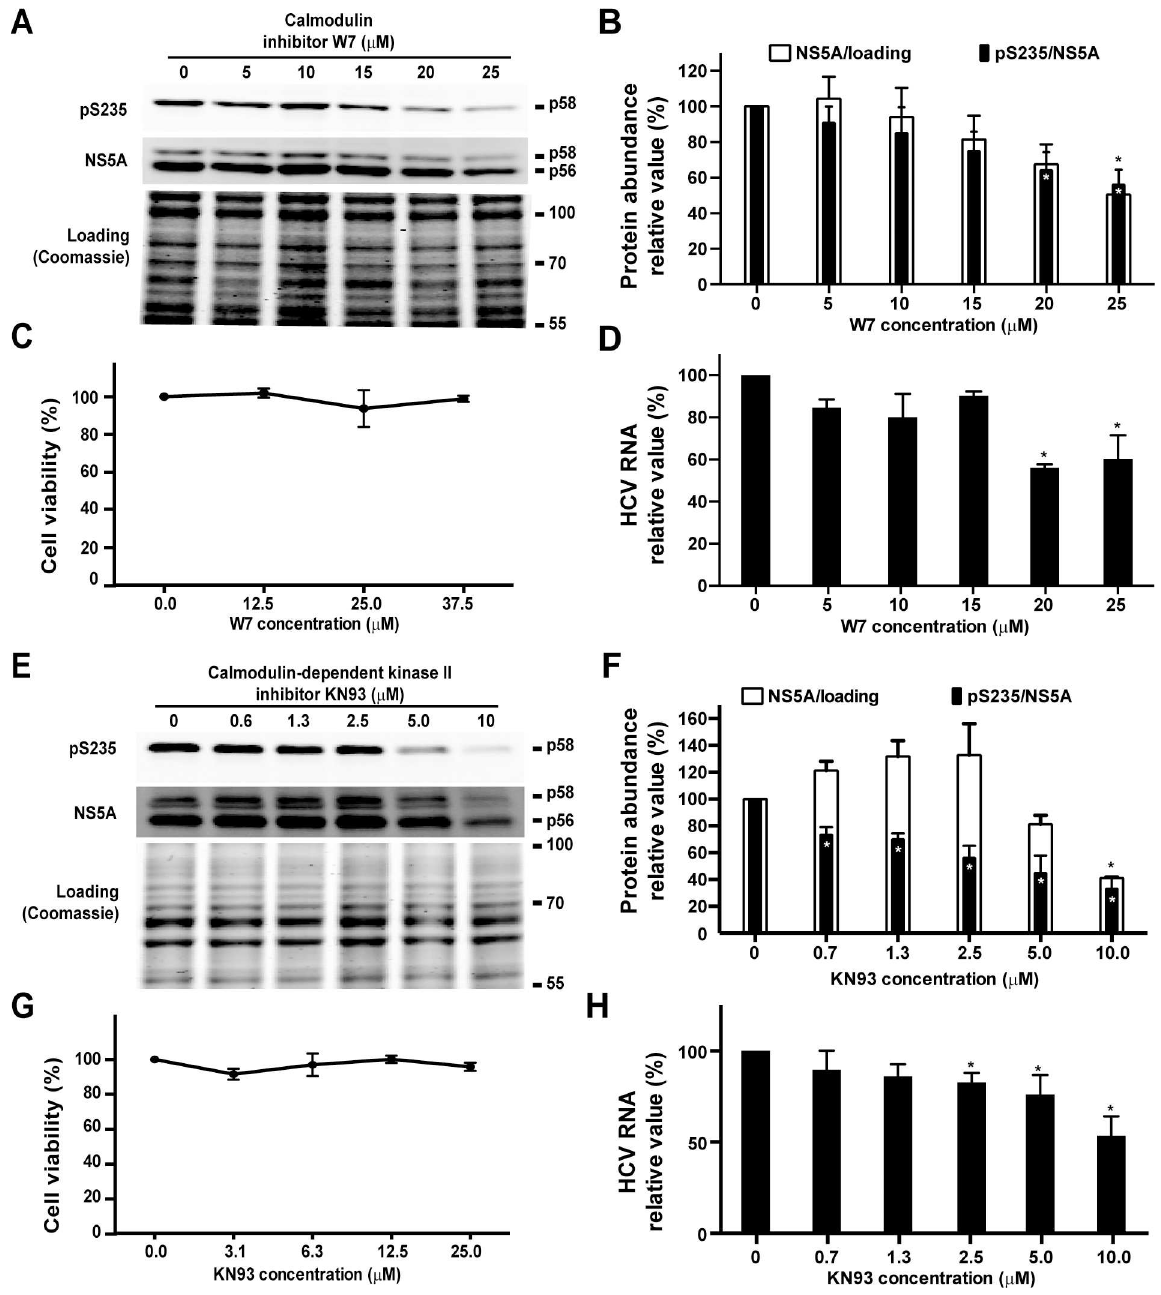
Fig 3. Calmodulin and CaMKII inhibitors reduced NS5A S235 phosphorylation and HCV RNA levels in the infected Huh7.5.1 cells. (A and E) Representative and (B and F) summary of the immunoblotting for NS5A and NS5A phosphorylation at S235 (pS235) in the HCV (J6/JFH1)-infected Huh7.5.1cells. The HCV-infected cells (3 days) were exposed to the inhibitorsfor 1 day before the immunoblotting analysis.Values are Mean ± SEM (n = 3). Asterisk indicatessignificance i.e. p < 0.05,t-test againstthe values in the vehiclecontrols (0 μ M). Protein abundancewas quantified with the Li-Cor scanner, adjusted for the loadings (i.e. Coomassie staining) and normalized with the values in the vehicle control cells (0 μ M). (C and G) Cell viabilityassessed with the MTT assay. The cells were exposedto the inhibitorsfor 1 day before the MTT assay. (D and H) Quantitative measurements of the HCV RNA levels in the HCV-infected Huh7.5.1cells exposedto the inhibitors.The experiments were done as those in a-c and e-g except that RNA was collectedfor the analysis. The GAPDH mRNA levels were analyzedin parallelfor the loadings.RelativeRNA abundancewas normalized to the values of the vehiclecontrols (0 μ